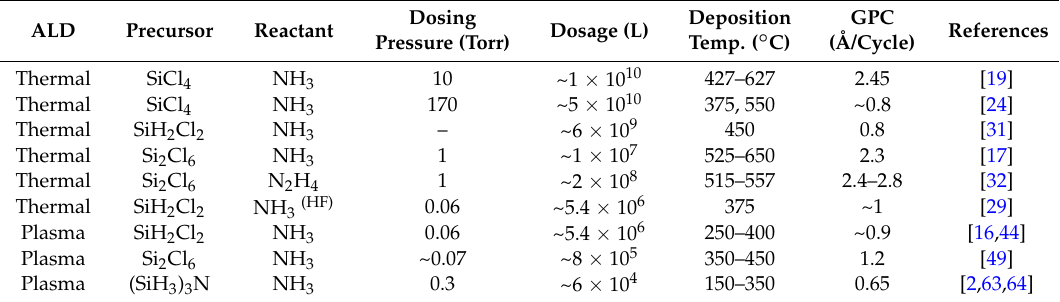
Table 4. Examples of the precursor dosage employed in SiN x ALD for the saturation